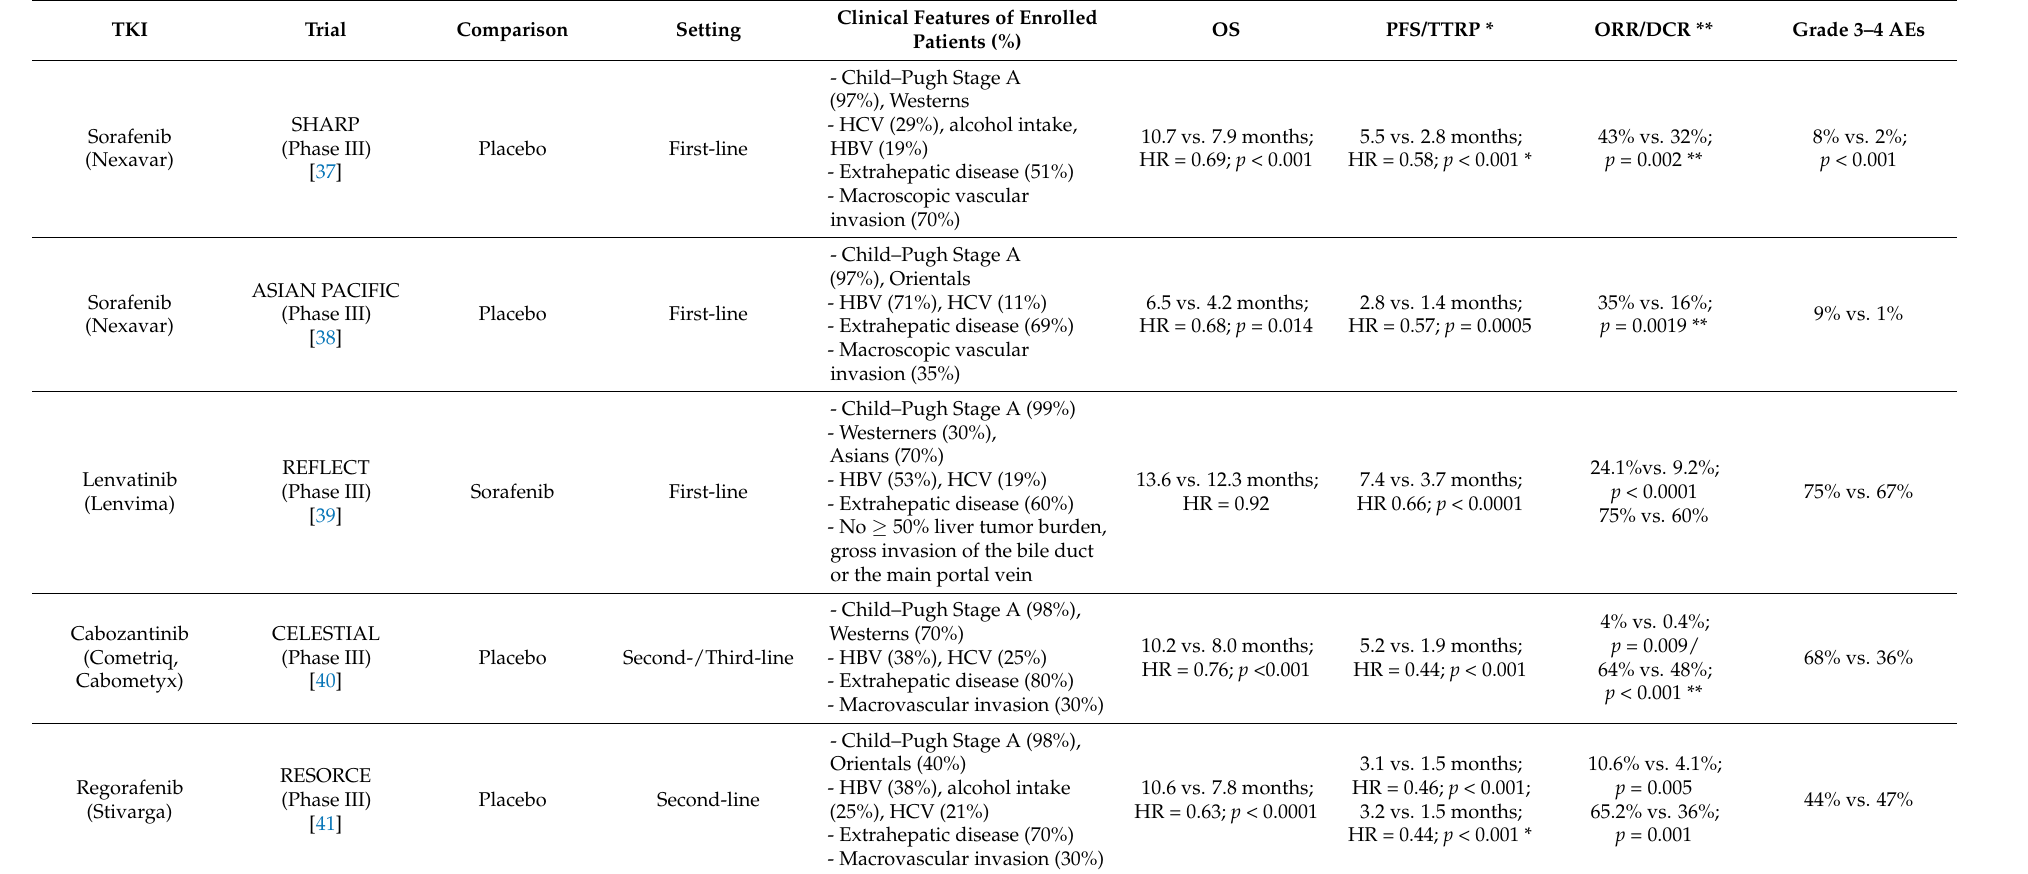
Table 1. Tyrosine kinase inhibitors for the treatment of advanced